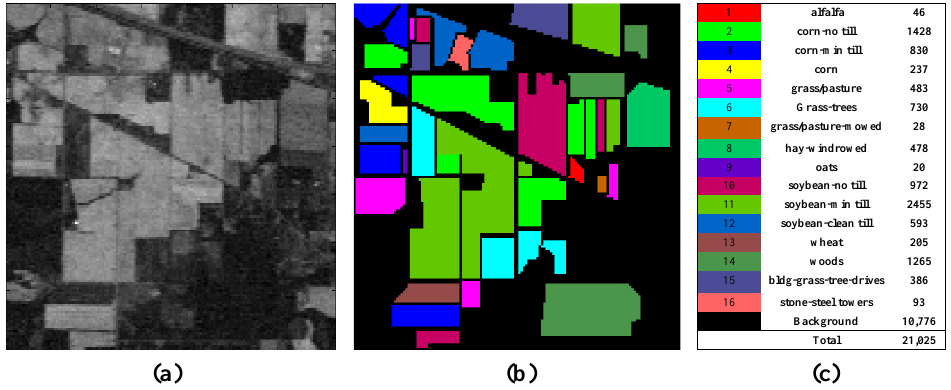
Figure 7. Indian Pines imagery: ( a ) color composite with RGB, ( b ) ground truth, and ( c ) category names with labeled samples.